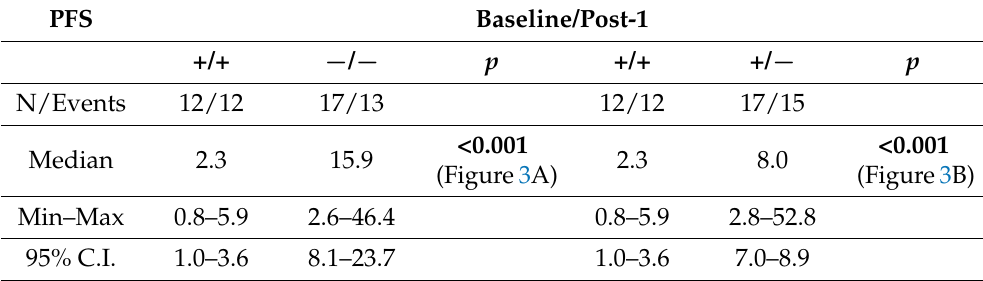
Table 5. PFS and OS according to changes in ctDNA at Baseline, Post-1, and the